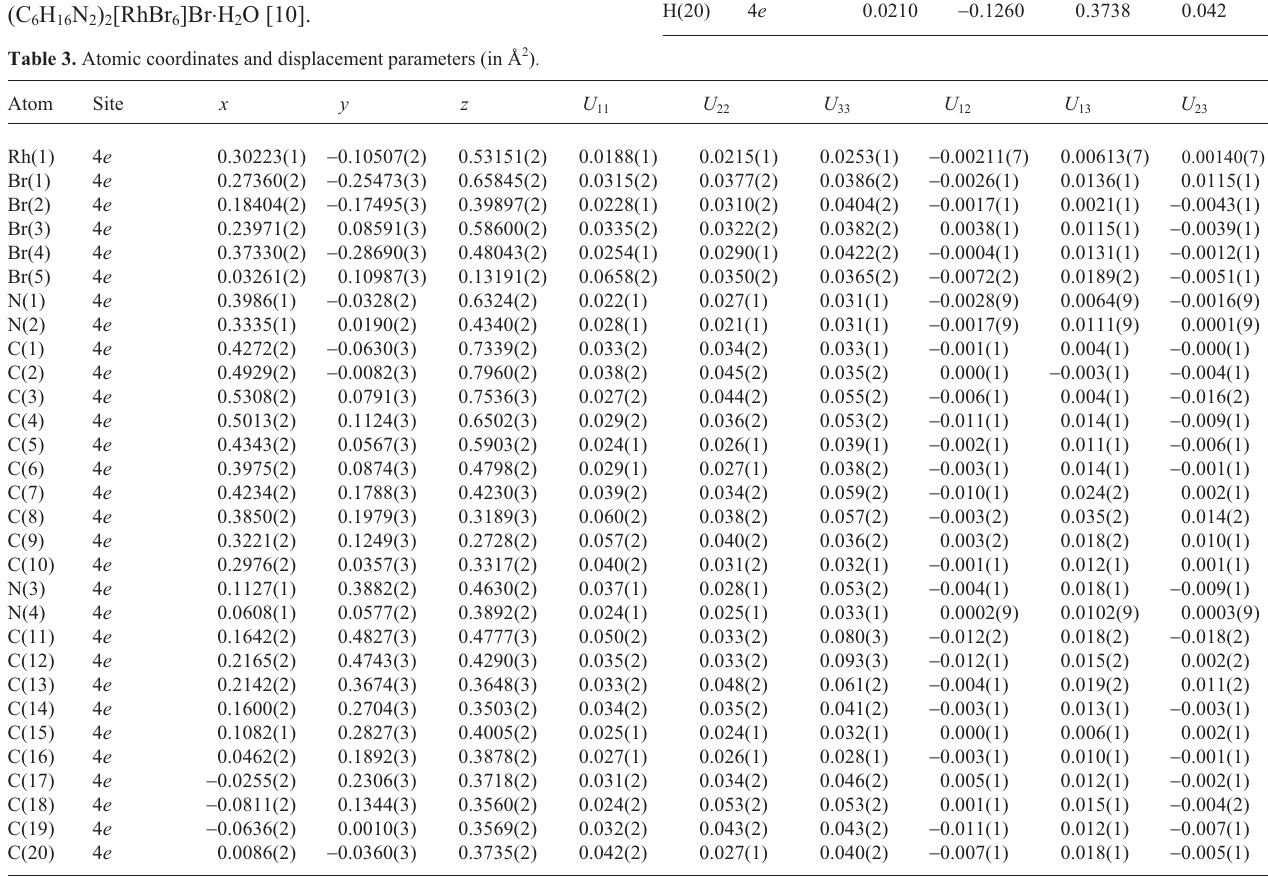
Table 3. Atomic coordinates and displacement parameters (in Å 2 )